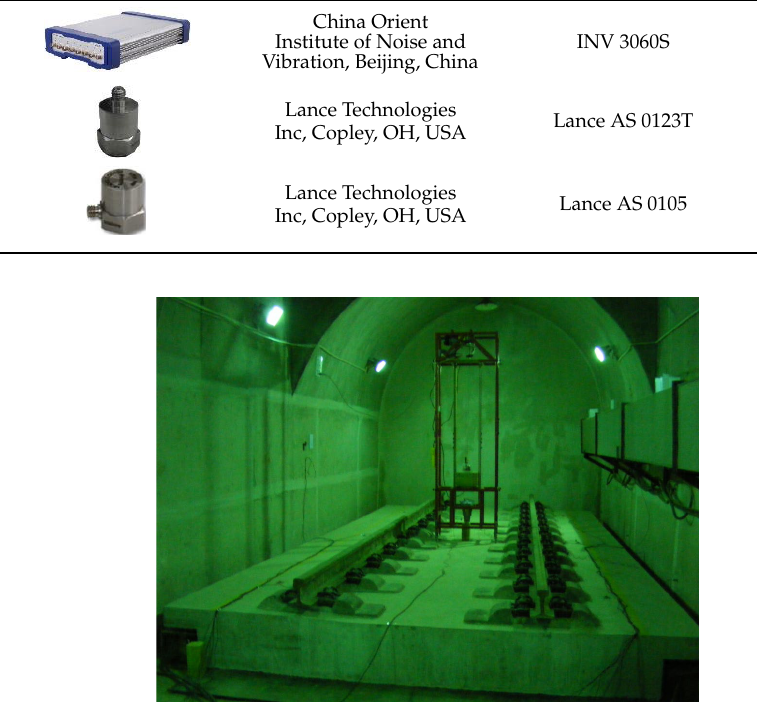
Figure 6. Test site diagram .